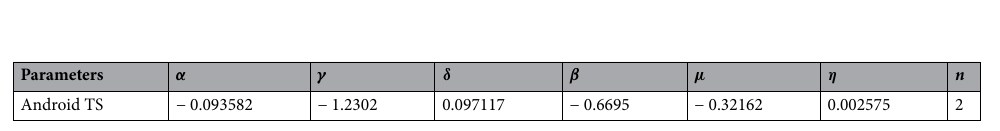
Figure 5. Absolute percentage forecast error E : deterministic versus stochastic approach, components x and y (Android market share data).